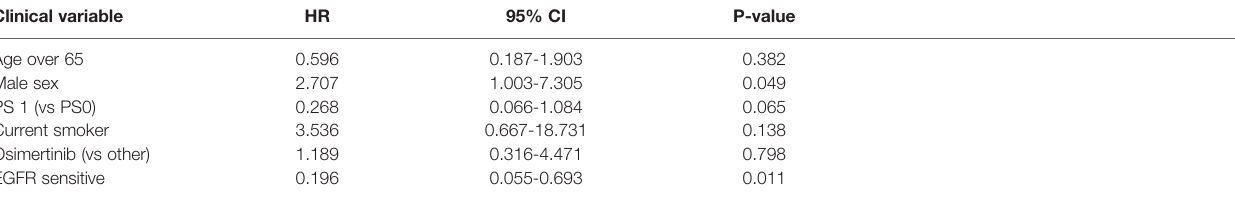
TABLE 2D | Multivariable